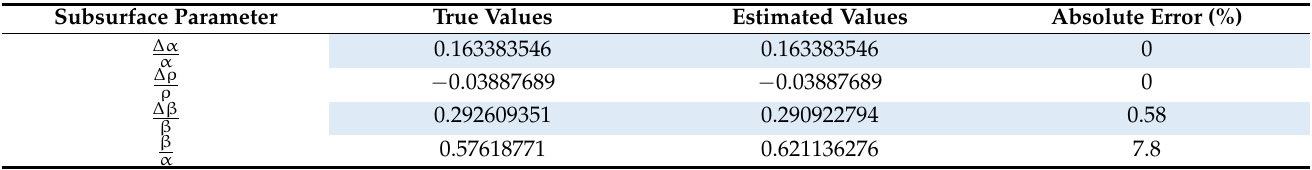
Table 4. Subsurface parameter values and absolute errors for CTP 38 in the oil reservoir.